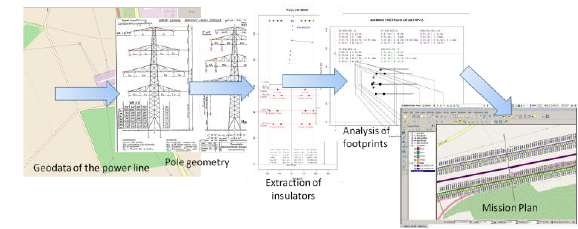
Figure 3. Schematic workflow of the mission planning.